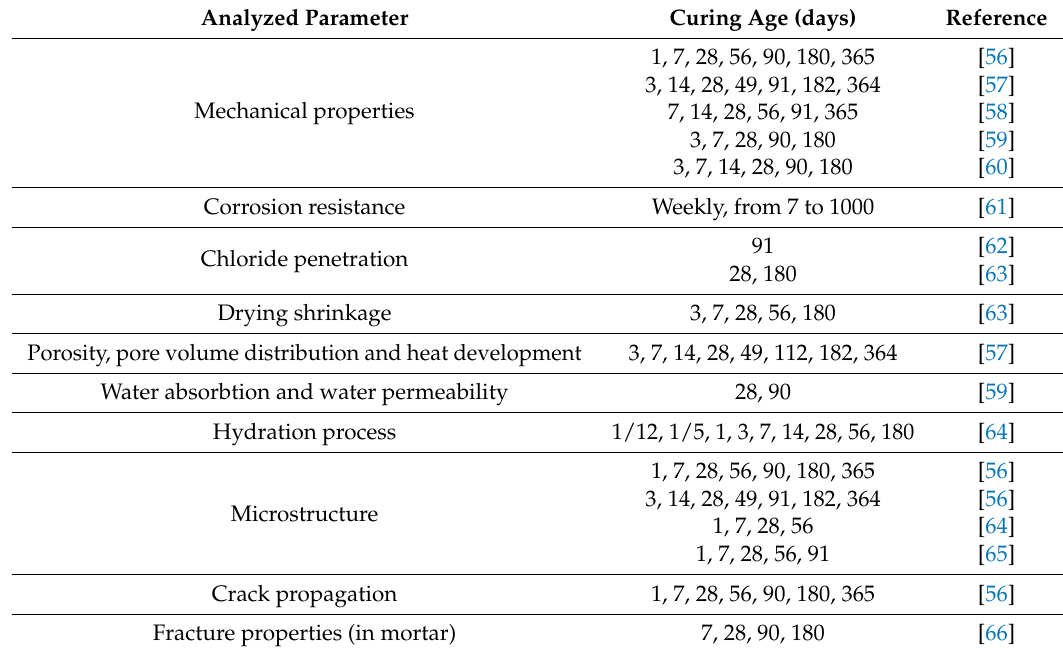
Table 1. Papers which presented test results of effect of curing time on the parameters of low calcium fly ash (LCFA)